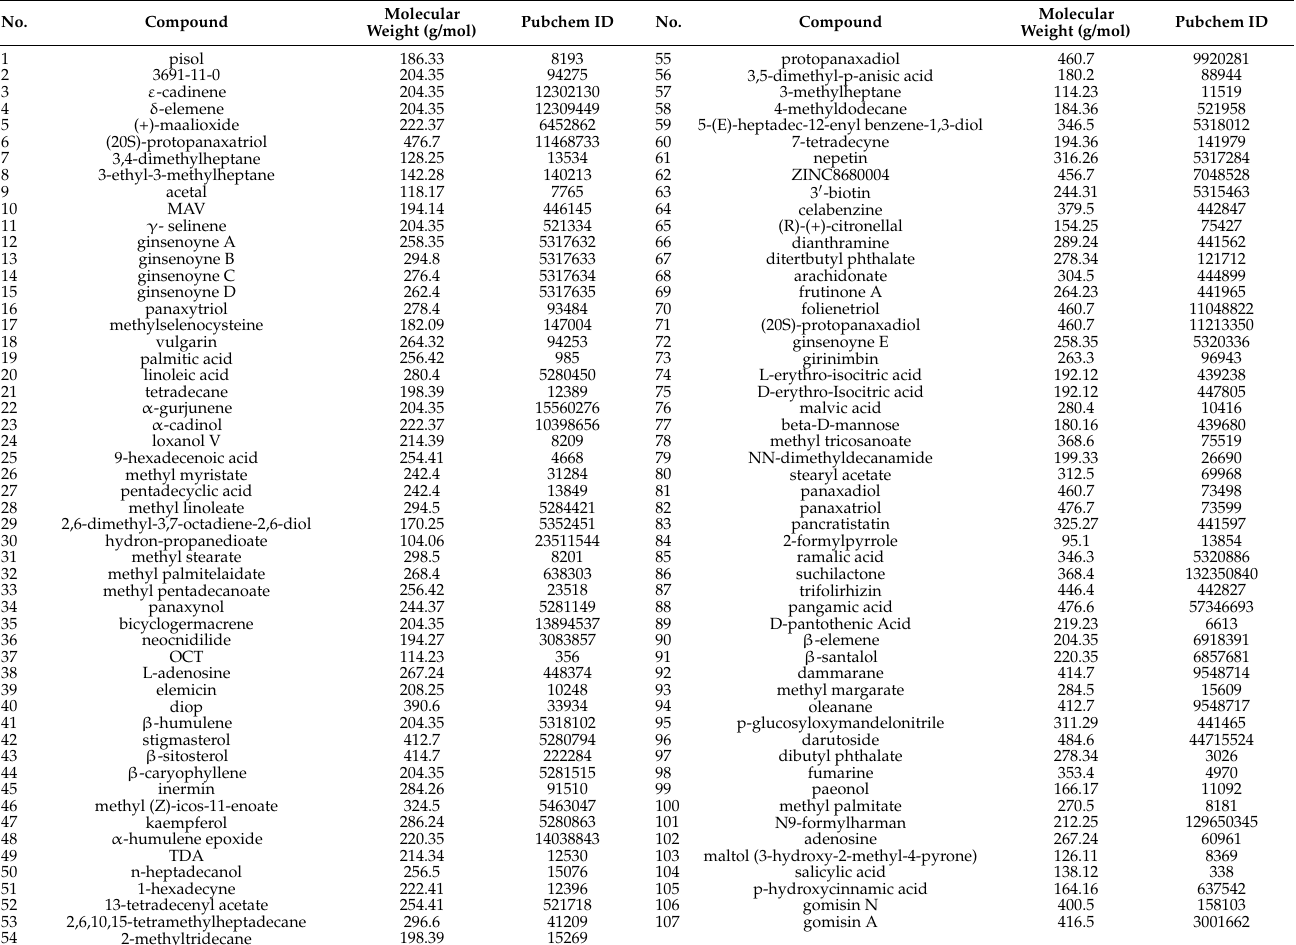
Table 1. A final list of the selected 107 compounds in PGCAM for network analysis based on Lipinski’s